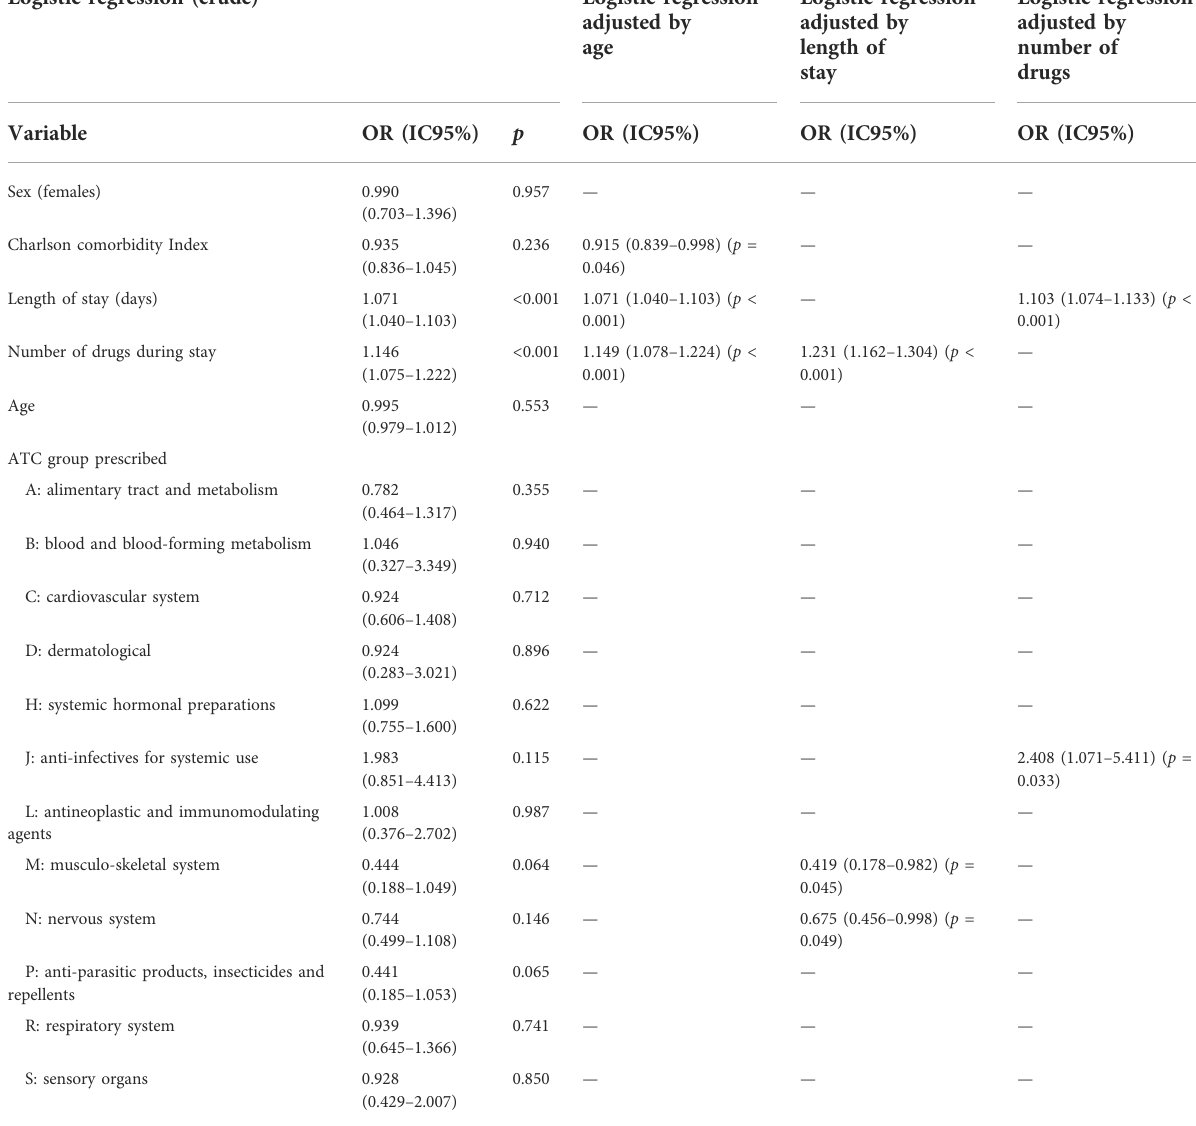
TABLE 2 Logistical regression. Patient variables associated with the presence of at least one DRP. Logistic regression